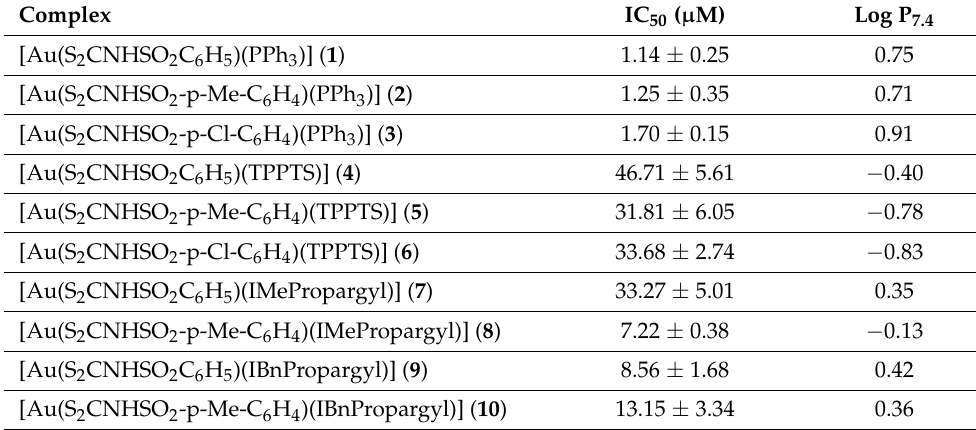
Table 1. IC 50 values obtained after treatment for 72 h with dithiocarbamate gold(I) complexes derived from sulfonamides on Caco-2 cells, along with the distribution coefficients (log P 7.4 ). Complex